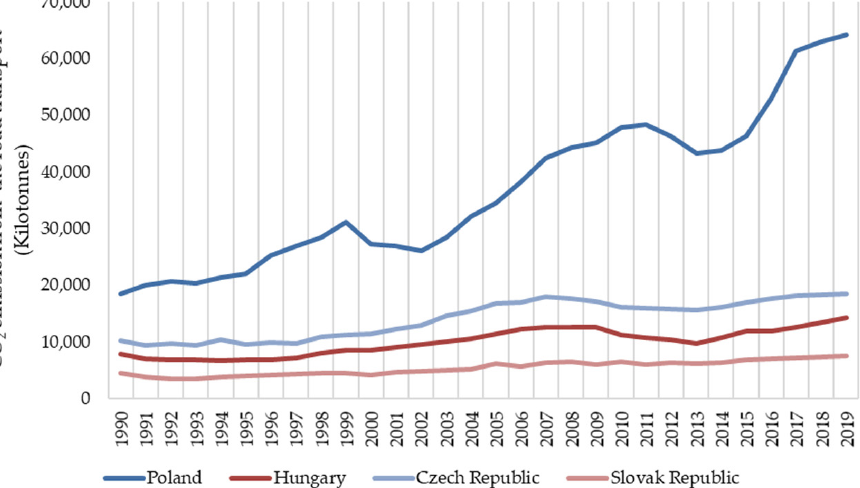
Figure 3. A plot of CO 2 emissions from road transport for V4 countries in 1990–2019 (kilotonnes). Source: UNFCCC database.